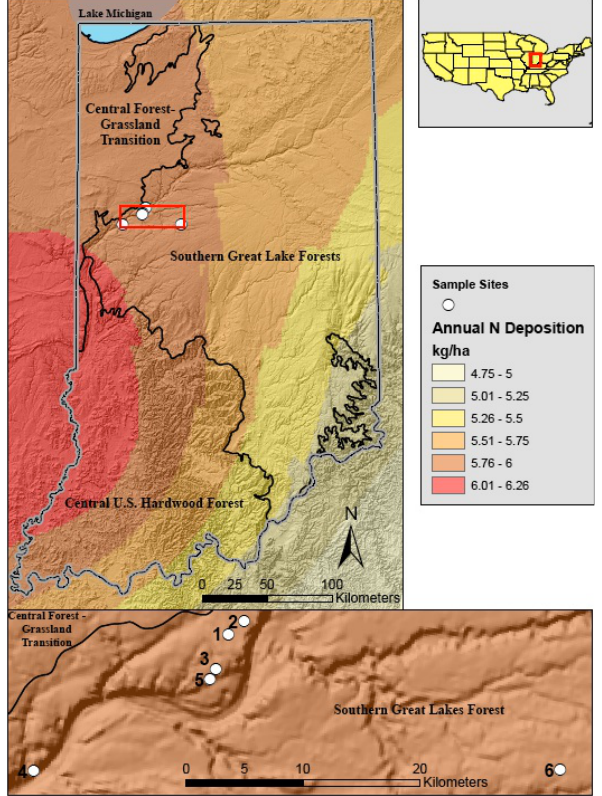
Fig. 1. Locations of six study sites in Indiana, with interpolated N deposition from the National Atmospheric Deposition Program, ecoregions delineated by the World Wildlife Fund, and topography from the United States Geological Survey. On the lower panel, 1 is Cumberland Woods, 2 is Rosebank Woods, 3 is McCormick Woods, 4 is Black Rock Barrens, 5 is Purdue Arboretum, and 6 is Bryan